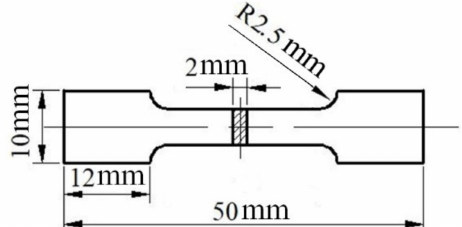
Figure 2. Standard tensile test plate of the Al-7Si-0.55Mg